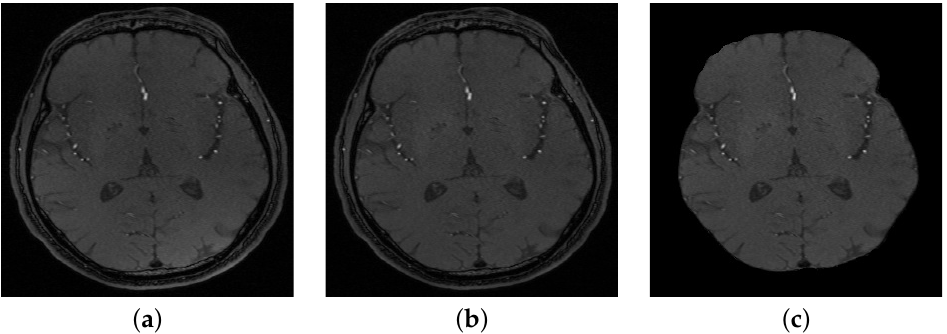
Table 3. MAP BP-based dataset demographics statistics.